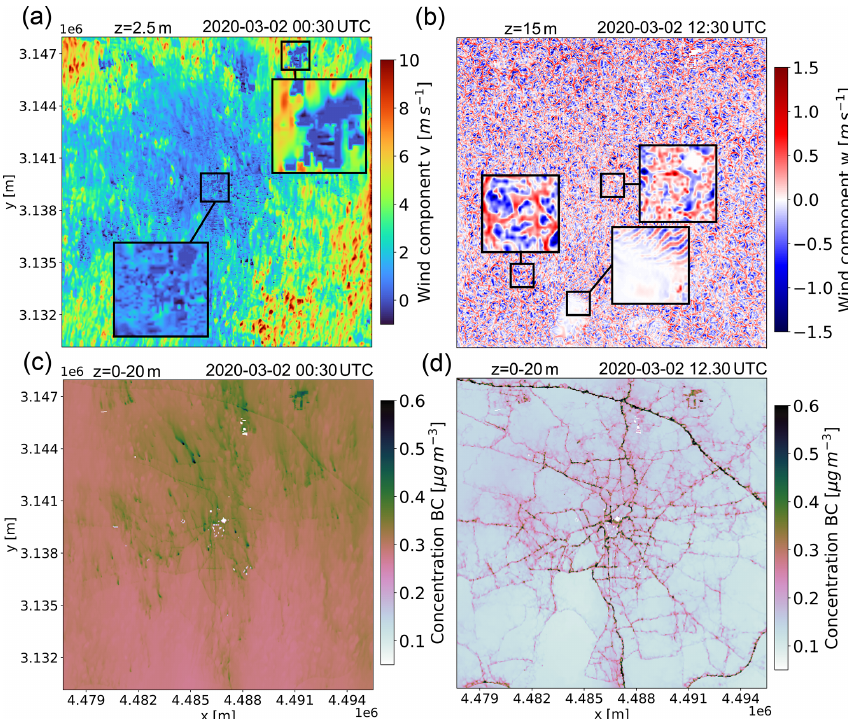
Figure 13. Horizontal map plots of simulation results with domain L0 (40m) for two contrasting PBL cases: (a) shows the near-surface wind component v for a stably stratified PBL, (b) the vertical component w for a convective PBL. The insets show a local magnification of some interesting flow features. In (c) and (d) , the corresponding concentration fields for BC averaged within the height range 0–20m are